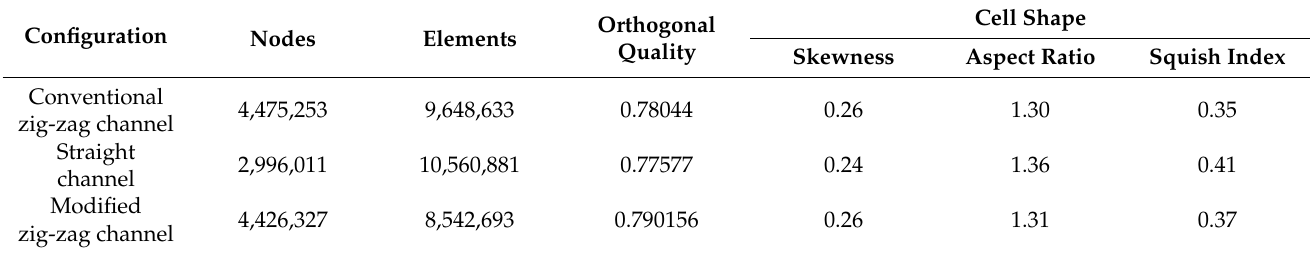
Table 2. Mesh features of the computational domain.